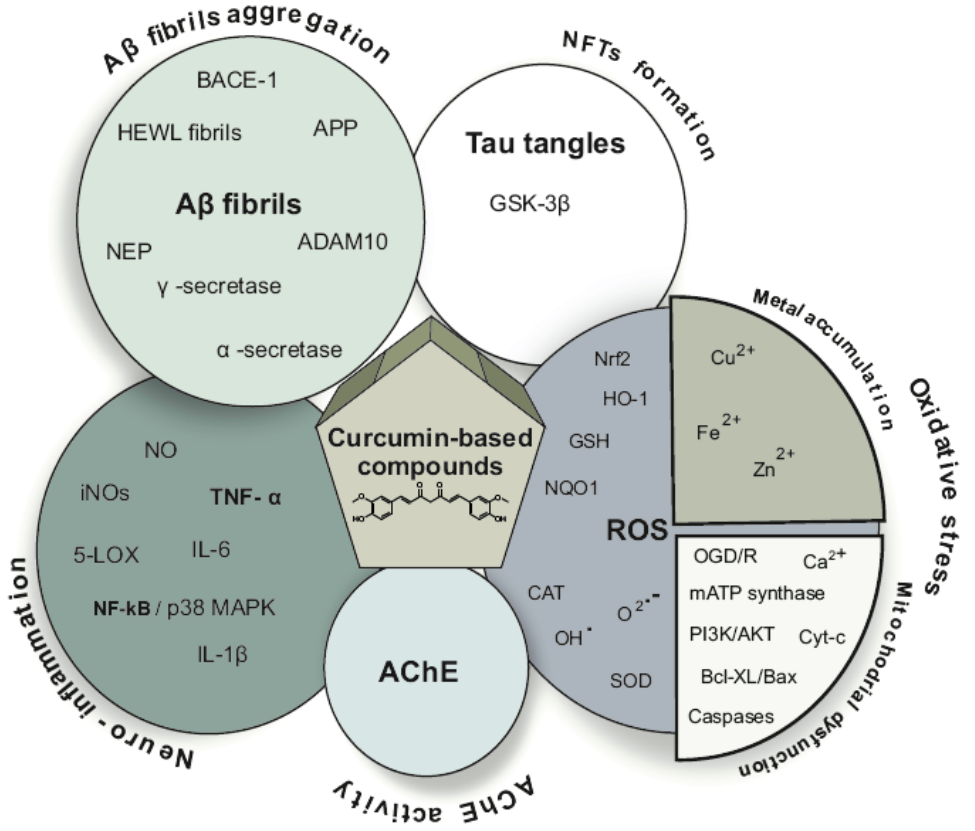
Figure 18. Therapeutic targets of curcumin analogues, derivatives, and hybrids in